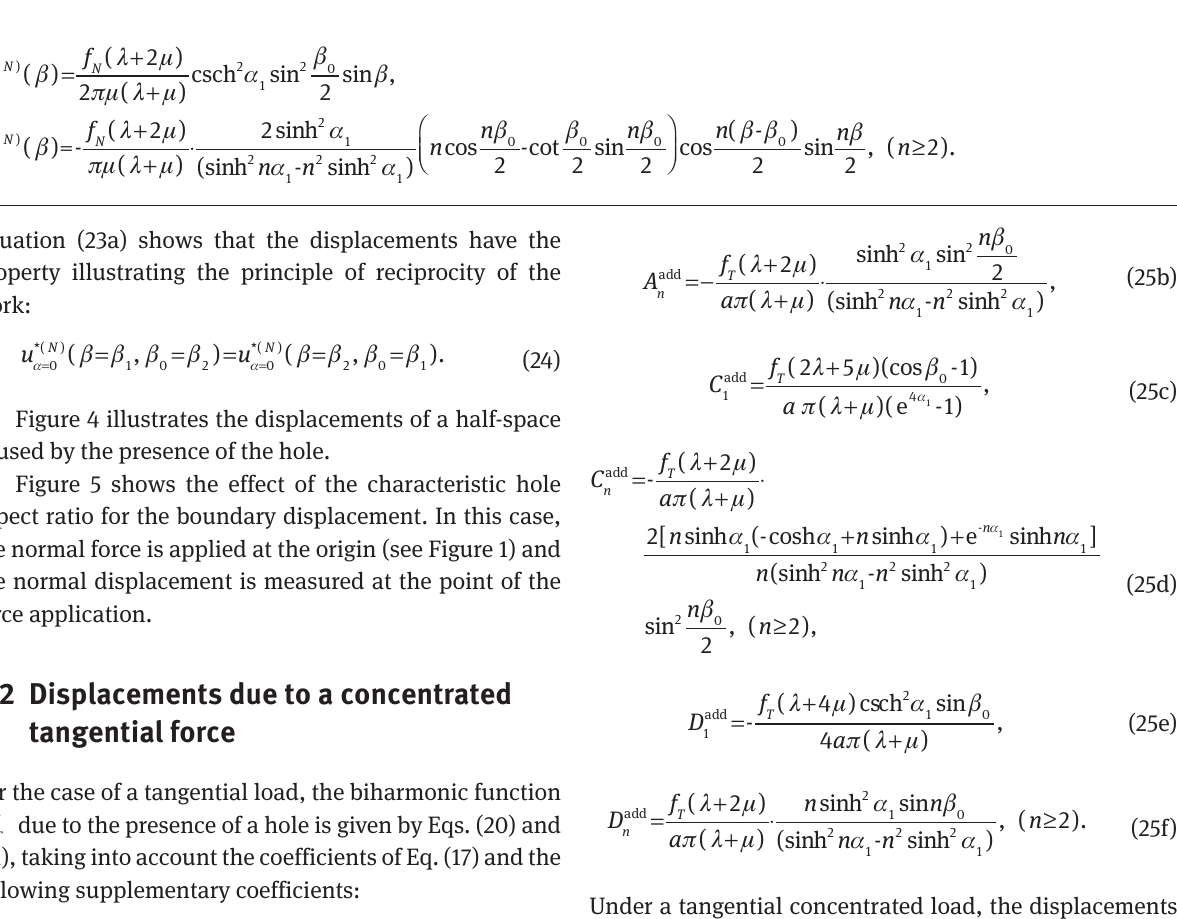
*( ) N u (A) and the tangential α = 0